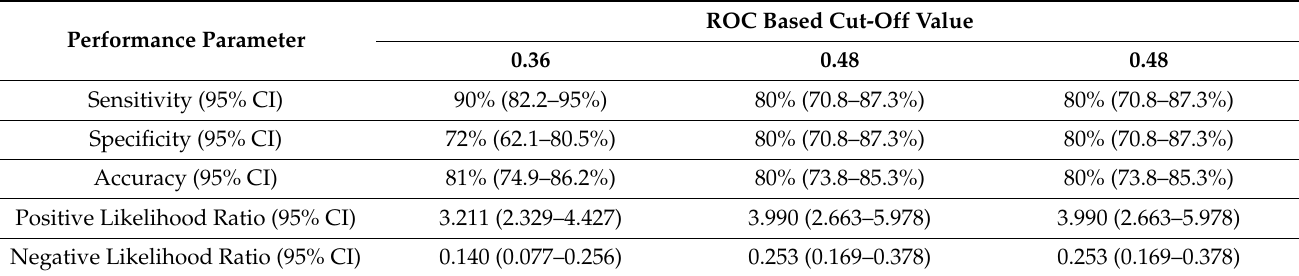
Table 2. Clinical performance of the IMMY s¯ona Aspergillus GM lateral flow assay when testing serum samples from non-neutropenic patients with pulmonary infections and control healthy individuals using ROC based cut-off values.